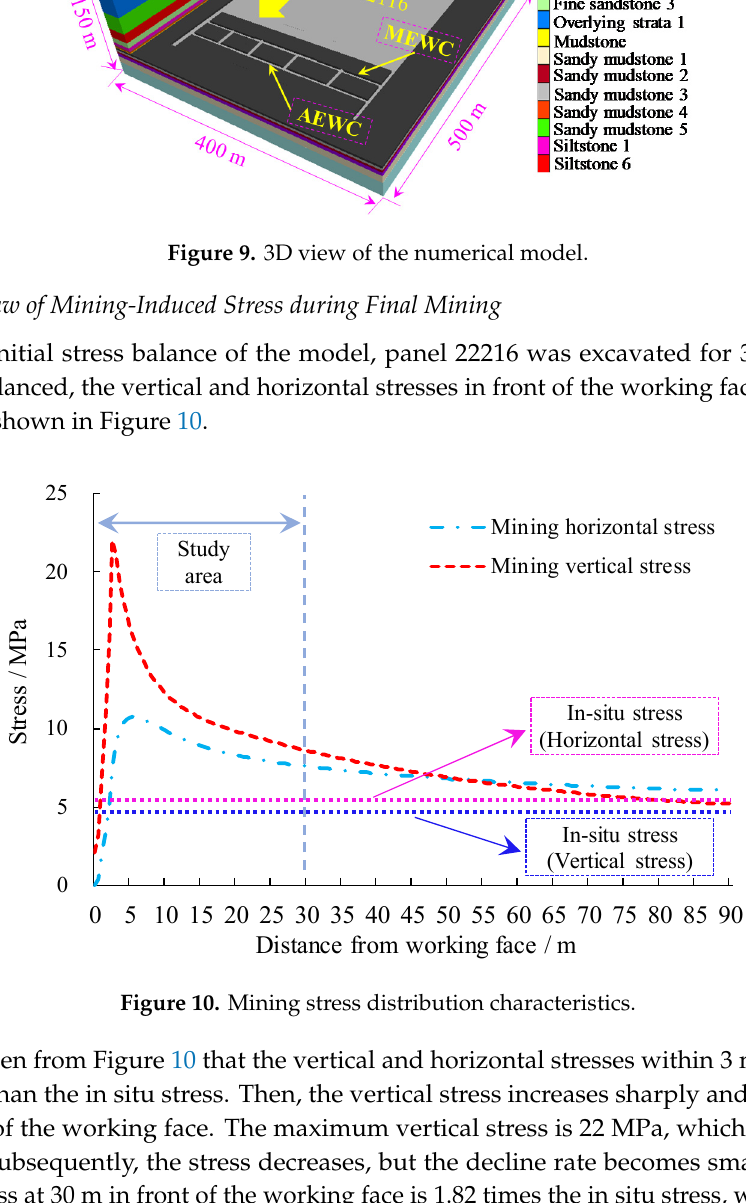
Figure 10. Mining stress distribution characteristics.